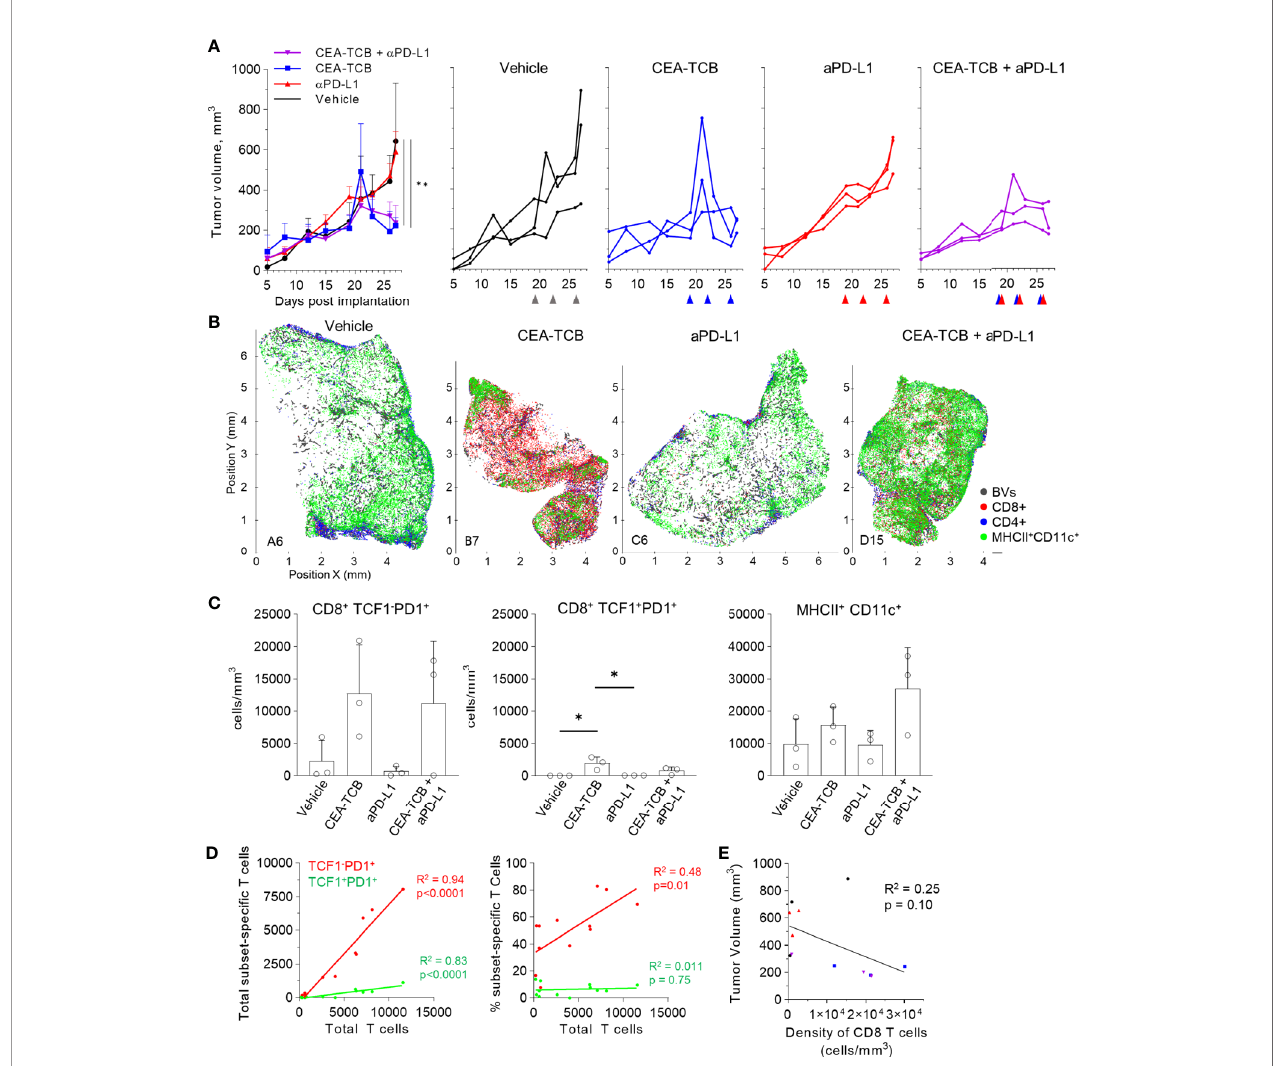
FIGURE 5 | Ef fi cacy of CEA-TCB and anti PDL-1 therapeutic interventions in the KPC-CEA tumor model. (A) KPC-CEA tumor-bearing mice treated with the indicated immunotherapies starting 19 days after implantation. Treatments were continued in 3d intervals as shown by arrows. Average tumor volume (left), and volume of individual samples (right) from each treatment group are shown. Data from one independent experiment (n= 3/group). One-Way ANOVA with Dunnett ’ s multiple comparison test. (B) Positional plots of color-coded objects de fi ned by histocytometry for select samples from each treatment group. (C) Density of CD8 + TCF1 - PD1 + (left), CD8 + TCF1 + PD1 + (center), or MHCII + CD11c + (right) cells by treatment group as identi fi ed by histocytometry. One-Way ANOVA with Tukey ’ s multiple comparison test. (D) Correlation between the total number of CD8 T cells and either the total number (left) or percent (right) of the indicated T cell subsets. (E) Correlation between the tumor volume and the density of CD8 T cells as identi fi ed by histocytometry. Data points represent individual samples. Bar graphs show mean, and error bars represent SD. *p < 0.05, **p <